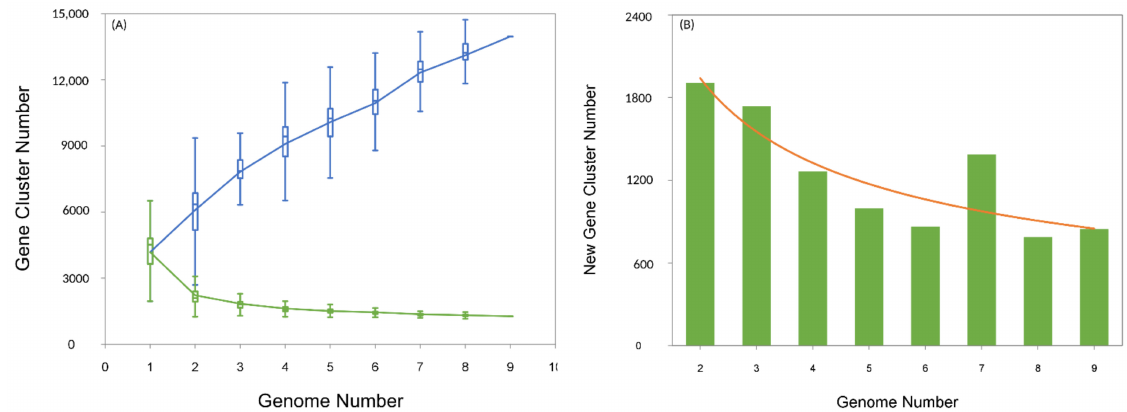
Figure 2. Pan-genome analysis of nine Aneurinibacillus species. ( A ) Core (green) vs. pan (blue) developmental plot. ( B ) Relationship between new genes and serial addition of sequenced